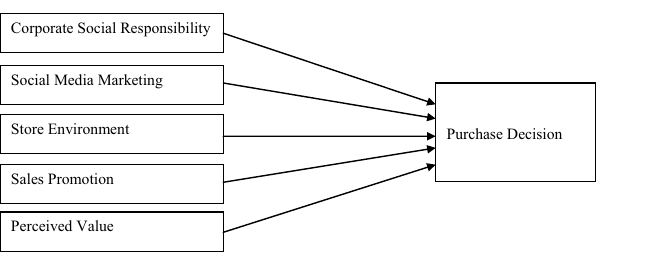
Figure 1. Research